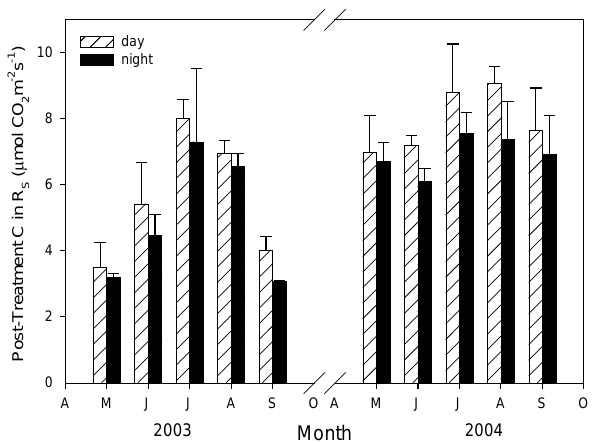
Fig. 2. The amount of post-treatment belowground C (C fixed after September 1996) to daytime (open bars) and nighttime (closed bars) soil respiration rates during the growing seasons of 2003 and 2004 at FACTS-1. Values are means ( n = 3) ± standard error.